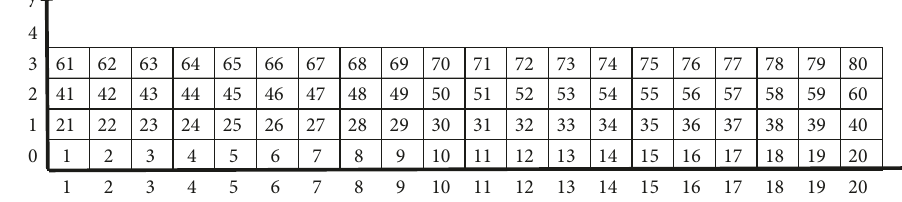
Figure 1: The grid method divides the space.